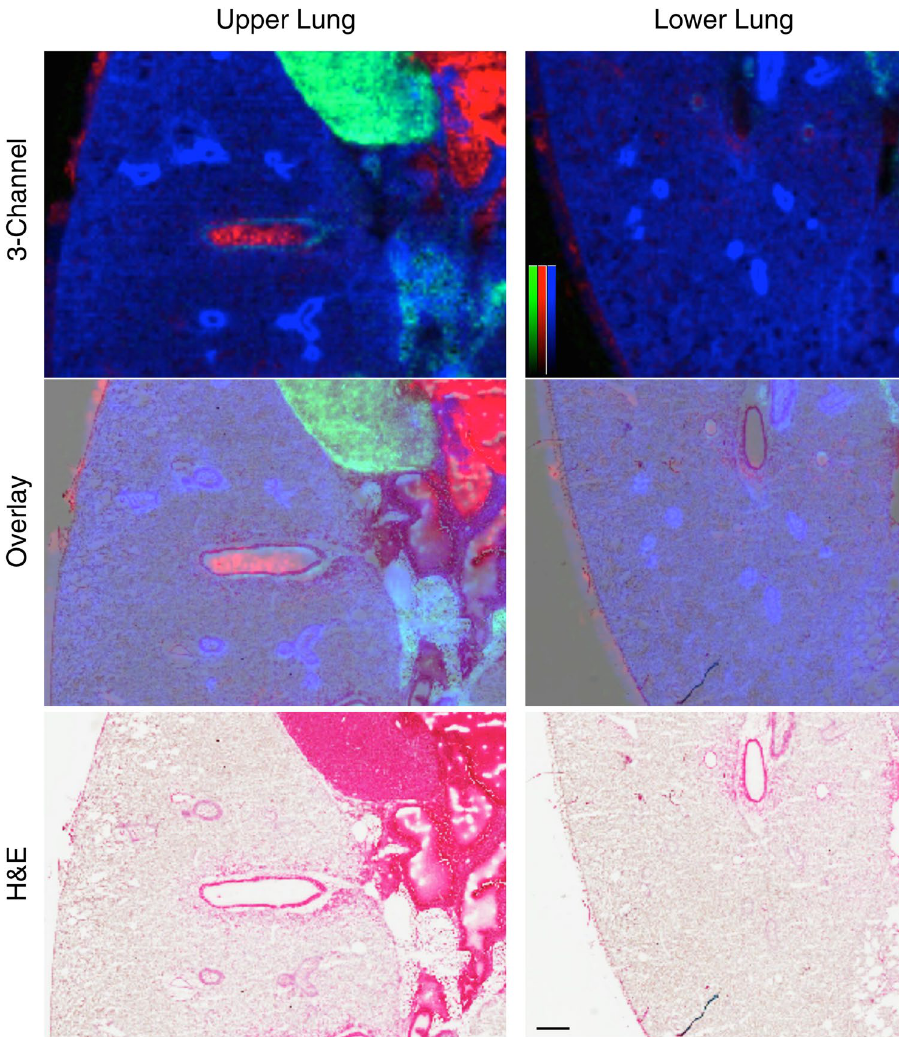
Figure 2. Deep lung fine structures are preserved edge-to-edge in gelatin inflated lungs. Mouse lung, gelatin inflated, MALDI-TOF in negative ion mode (50 μ m spatial resolution).Left panel: upper lung, with heart in view; Right panel: lower lung with intact, continuous serosa edge. Top panel: 3-channel (tricolor) reconstruction of heme (red, m/z 615.1), cardiolipin (green, m/z 1447.8), phosphatidylinositol [PI(38:4)-H] − (blue, m/z 885.5), normalized to TIC. Bottom: H&E staining of section, post-MSI. Middle: overlay of tricolor image and H&E. Color bars = 0–100% relative intensity. Scale bar = 500 μ